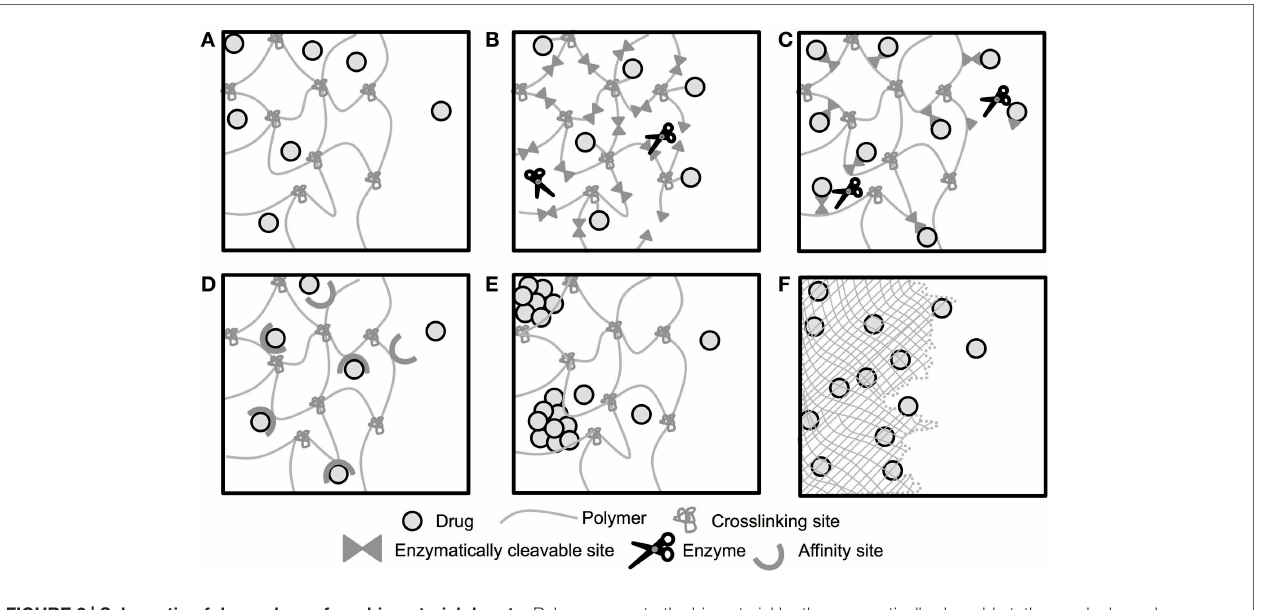
FiGURe 2 | Schematic of drug release from biomaterial depots . Release of drugs from depot-based biomaterials can be controlled by a number of mechanisms. (A) Drug is encapsulated within a biomaterial with large enough mesh/pore size to allow for diffusive release of the encapsulated drug. (B) Drug is tethered to a biomaterial that degrades in response to enzyme expression and releases the drug upon degradation of the biomaterial. (C) Drug is tethered